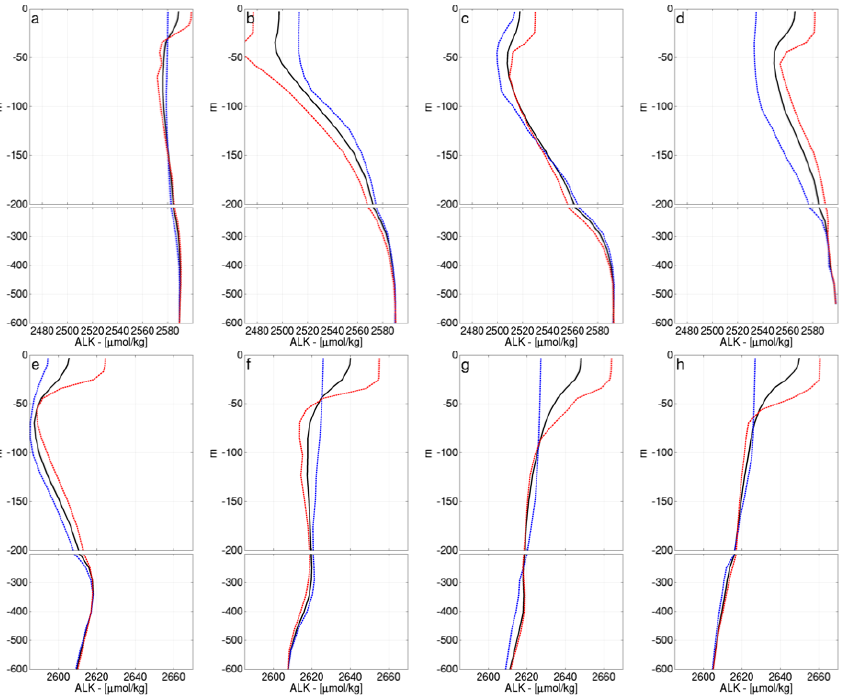
Figure 6. Mean annual vertical profiles of alkalinity (black line) in selected points of the Mediterranean Sea (points in Fig. 5). Mean annual range of variability between winter (blue line) and summer (red line)